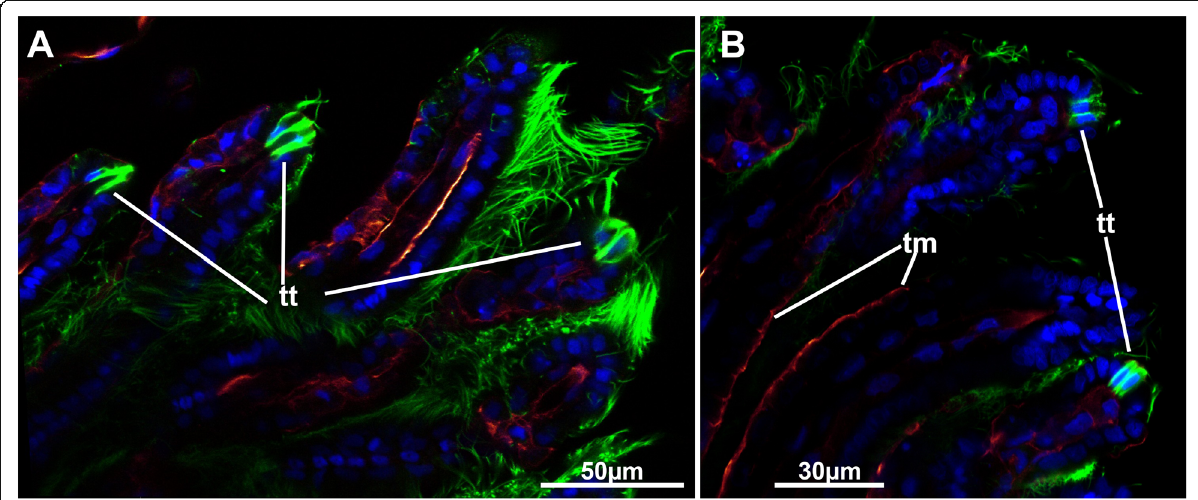
Fig. 9 Tentacle tips of Stephanella hina . Confocal laser scanning microscopy stacks based on acetylated alpha-tubulin labelling. Optical slices. Acetylated alpha-tubulin in green LUT, f-actin in glow LUT. a & b Different sections of tentacle tips showing distinct ciliary tips at the distal ends of the tentacles. Abbreviations: tm – tentacle muscle, tt – tentacle